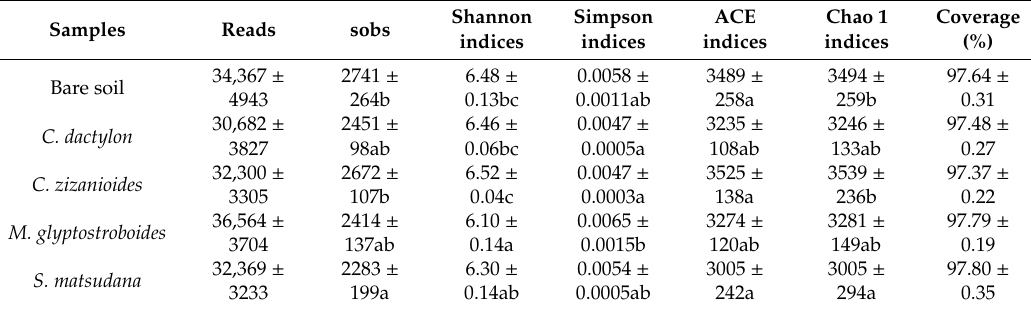
Figure 1. Rarefaction curves based on the sequencing results. Table 2. Estimation of bacterial community diversity (means of three replicates ± standard errors).